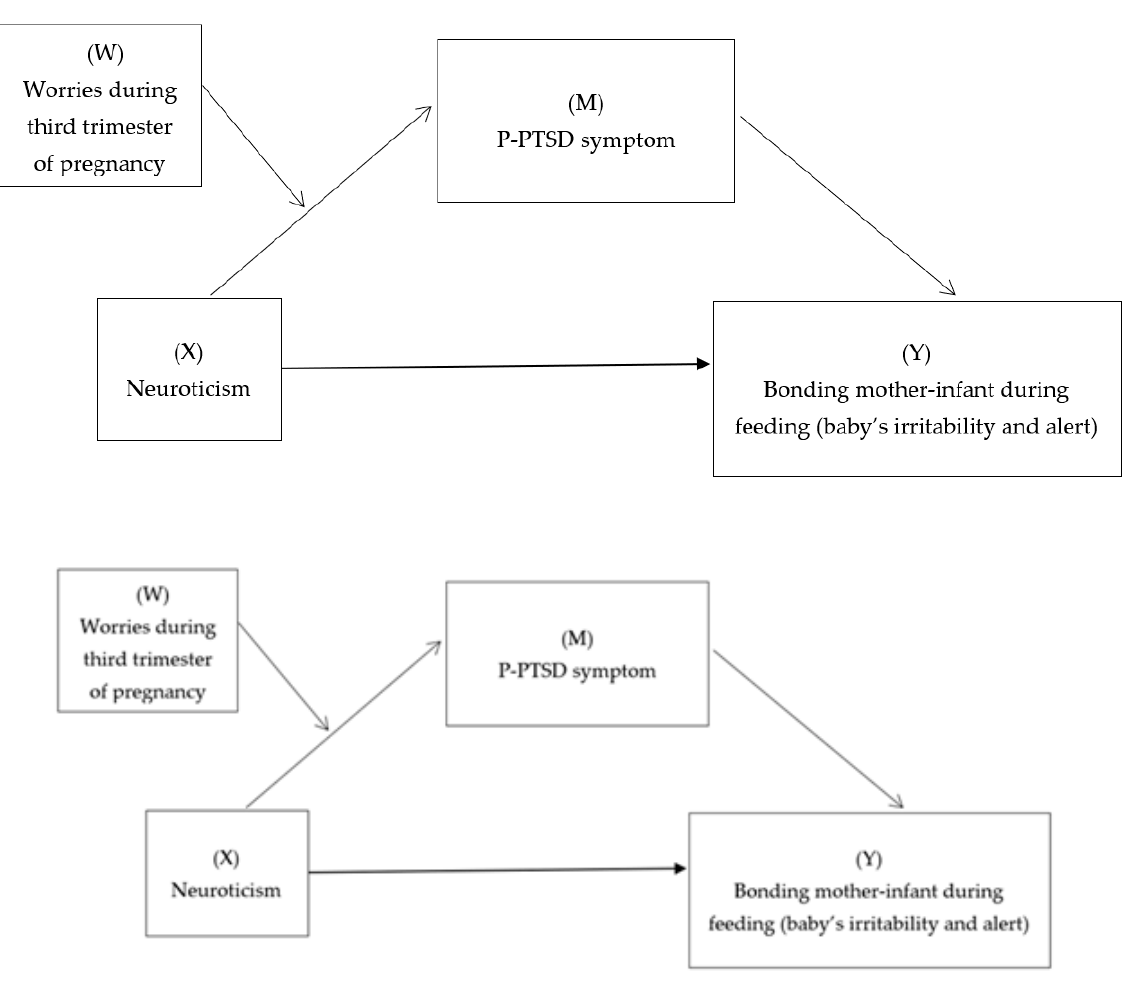
Figure 1. Conceptual moderated-mediation